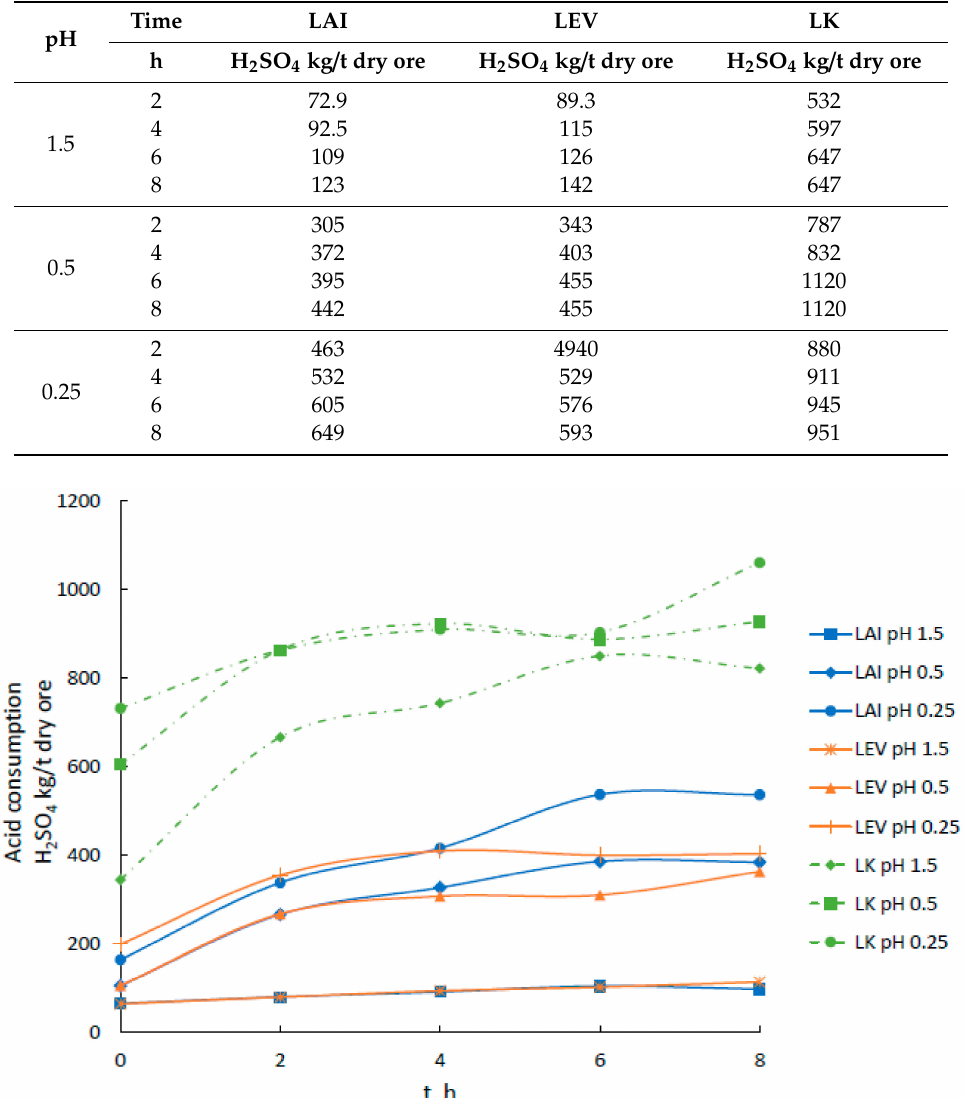
Figure 4. Calculated acid consumptions (H 2 SO 4 kg / t dry ore) during leaching of the LAI, LEV, and LK laterites in pH 0.25, 0.5, and 1.5. Parameters used in the experiments: 90 ◦ C, S / L = 30%, 800 rpm. pH was maintained by H 2 SO 4 addition. Acid consumptions were calculated based on solution